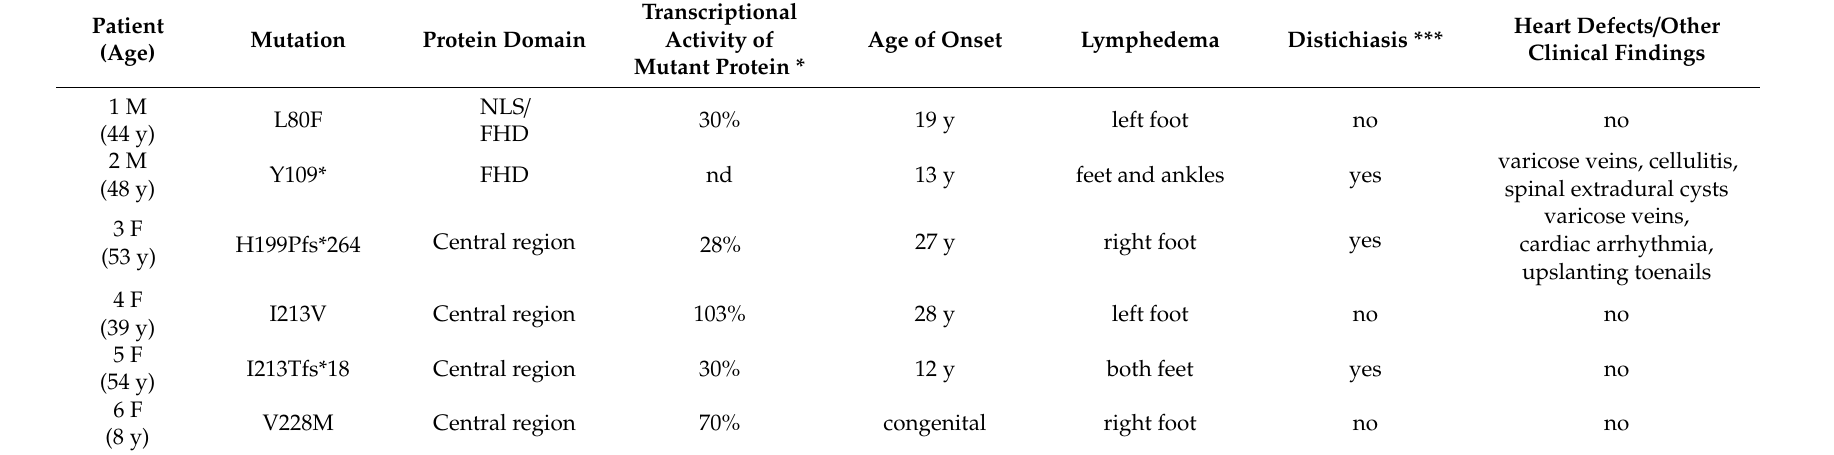
Table 1. Summary of molecular and clinical data of